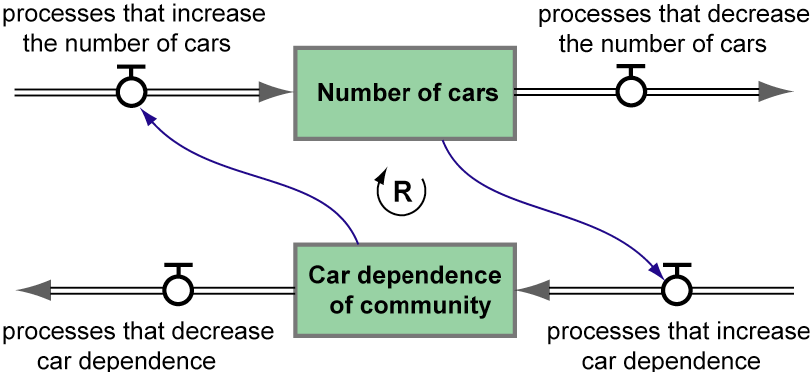
Figure 1. An illustrative stock-and-flow feedback structure. The rectangles represent stocks (accumulations). The double-lined arrows represent inflows and outflows (processes that change the amounts accumulated). The “tap” symbols represent process flow-rates. The single-lined arrows represent influence or information links. The encircled R in the centre of the diagram indicates that this is a reinforcing (positive) feedback